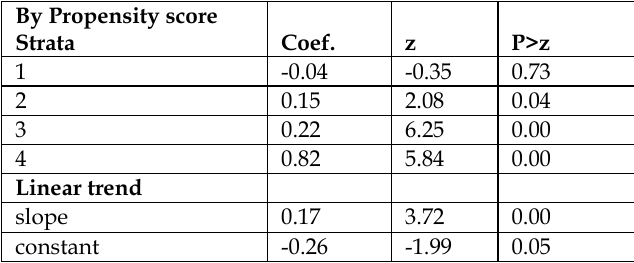
Table 2. The Distributional Effect of Road